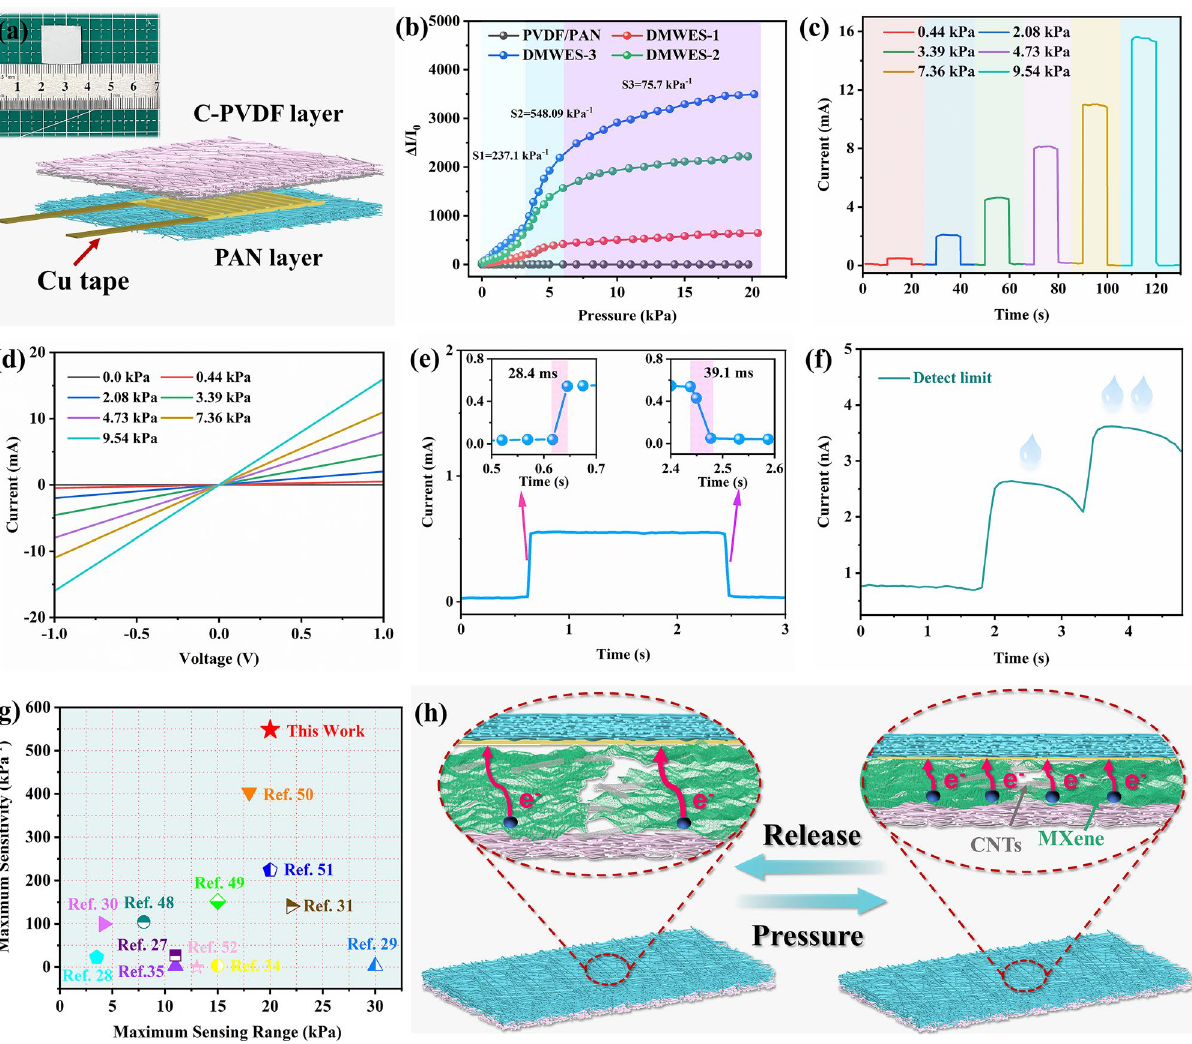
Fig. 4 Pressure sensing performance and the sensing mechanism of the DMWES. a Schematic illustration of the DMWES as pressure sensors. b Sensitivity curve of the DMWES with different electrospraying time. c Current response curves of the DMWES under serial pressures. d I-V curves of the DMWES under serial pressures. e Response and recovery time of the DMWES. f Detection limit of the DMWES. g Comparison of the maximum sensitivity and maximum sensing range with other reported studies. h Schematic illustration of the sensing mechanism of the